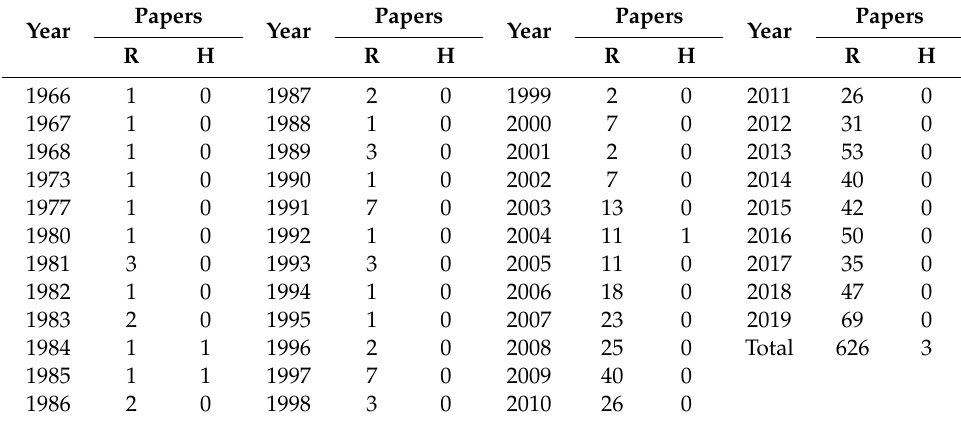
Table 1. Number of articles (per year) focused on the chemical analysis, compound isolation, and bioactivity of Rhodiola rosea roots / rhizomes (R) and herb (H) a